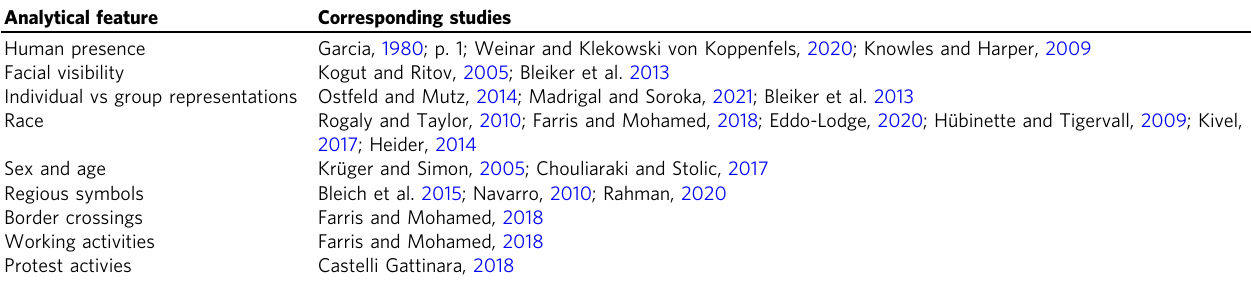
Table 2 Summary of analytical feature correspondence to previous research that motivated their inclusion in the